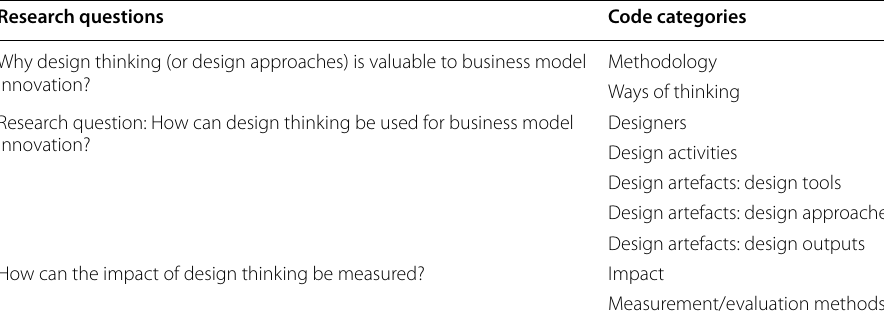
Table 2 Research questions and code